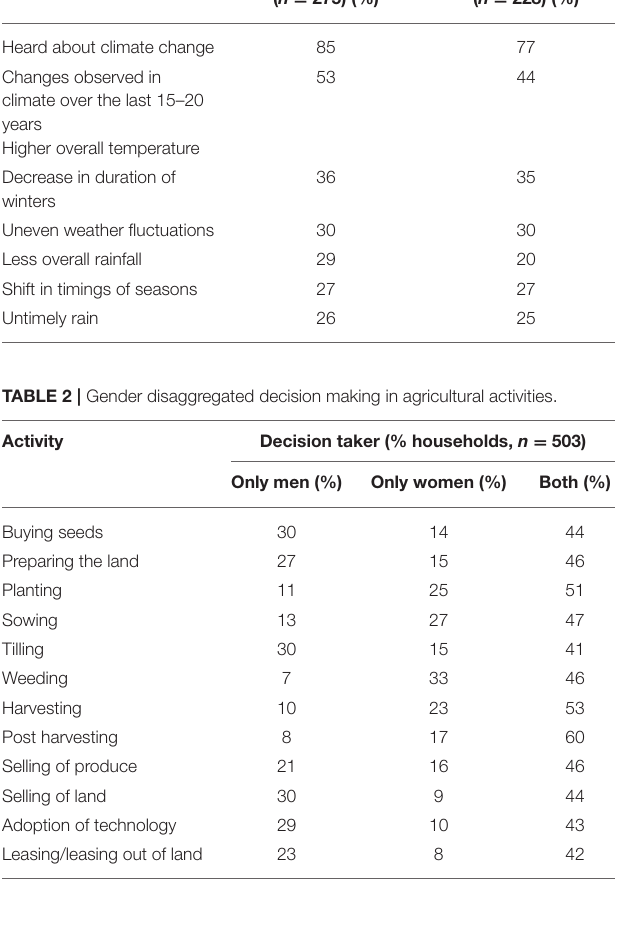
TABLE 3 | Major sources of climate change information for men and women farmers in Nepal. Sources of weather